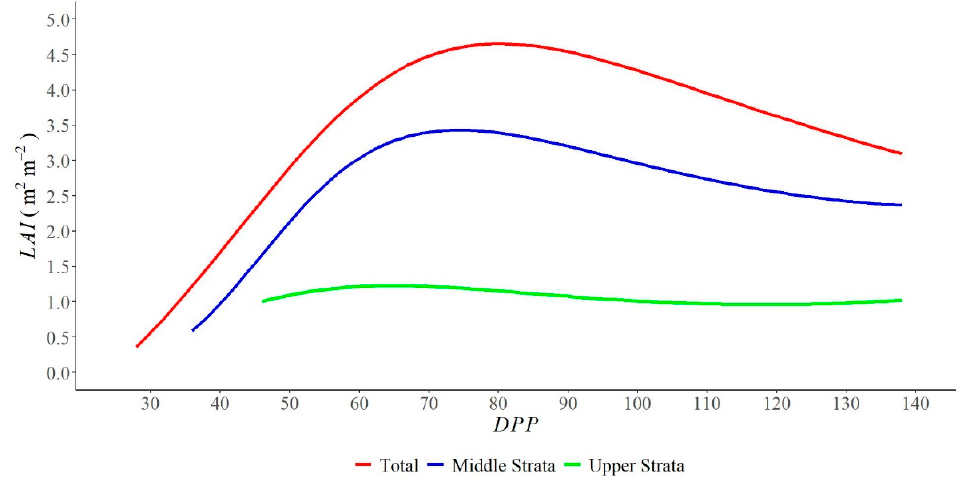
Figure 3. Accumulated leaf area index (LAI) through plant canopy, upper stratum (topmost unshaded leaves), middle stratum, and total of potatoes ( Solanum Tuberosum L. Var. Diacol capiro) versus days post planting (DPP).